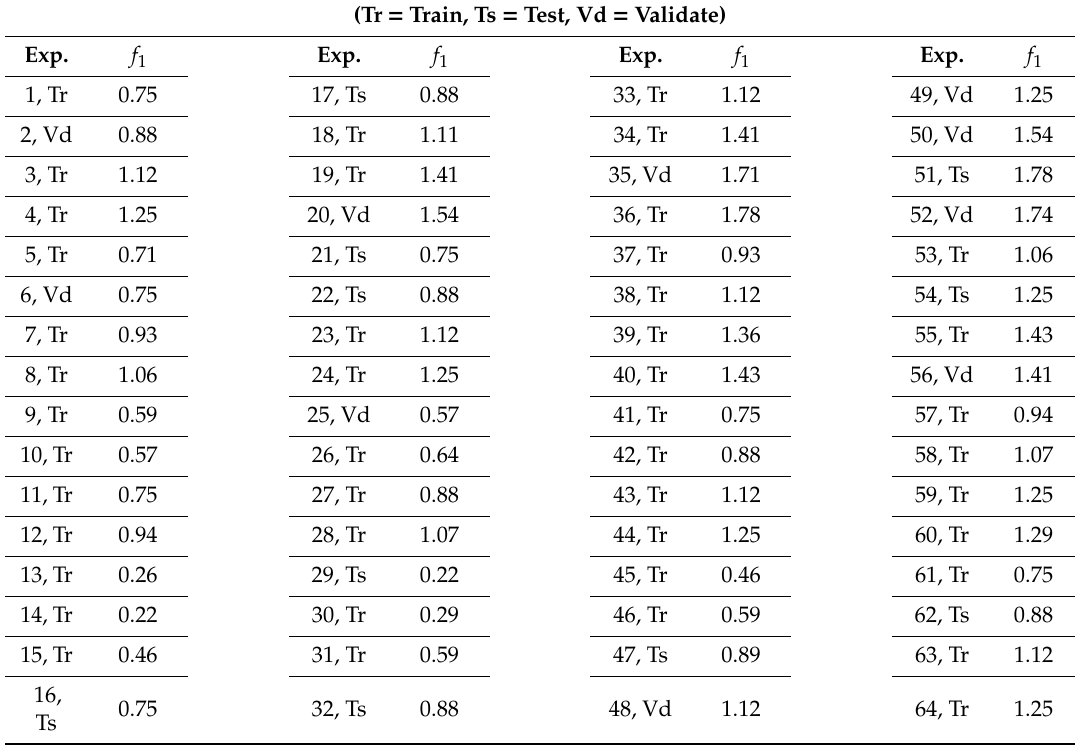
Table 3. Values obtained from type 2 function ( f 2 ) , where a 0 = 1, a 1 = 1,a 2 = 1.5, a 3 = 2. (Tr = Train, Ts = Test, Vd = Validate)